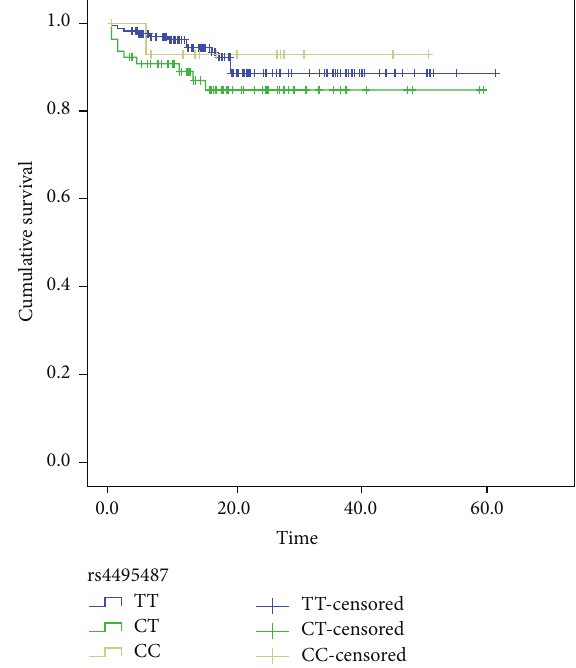
Figure 1: Kaplan-Meier estimates of overall survival by JAK2 rs4495487 genotypes ( 𝑃 = 0.299